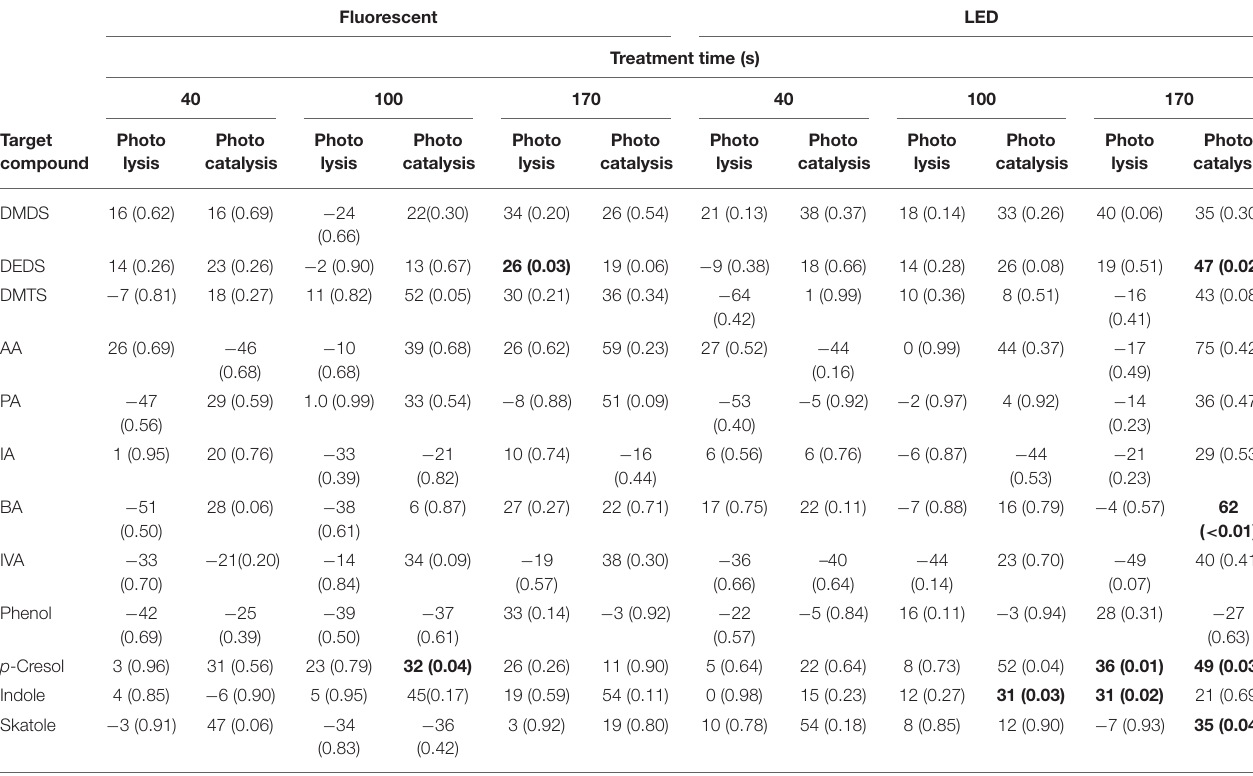
TABLE 4 | Mitigation of VOCs.